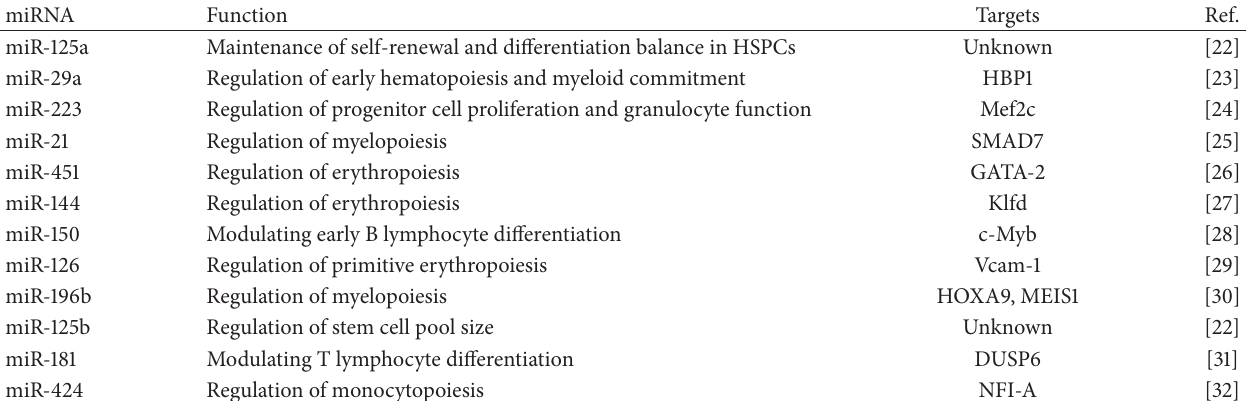
Table 1: miRNAs expressed in MSC-MVs that are involved in regulation of hematopoiesis.